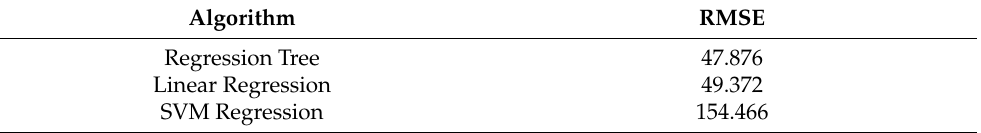
Table 4. Performance of regression algorithms for predicting terminal disruption based on the terminal attribute